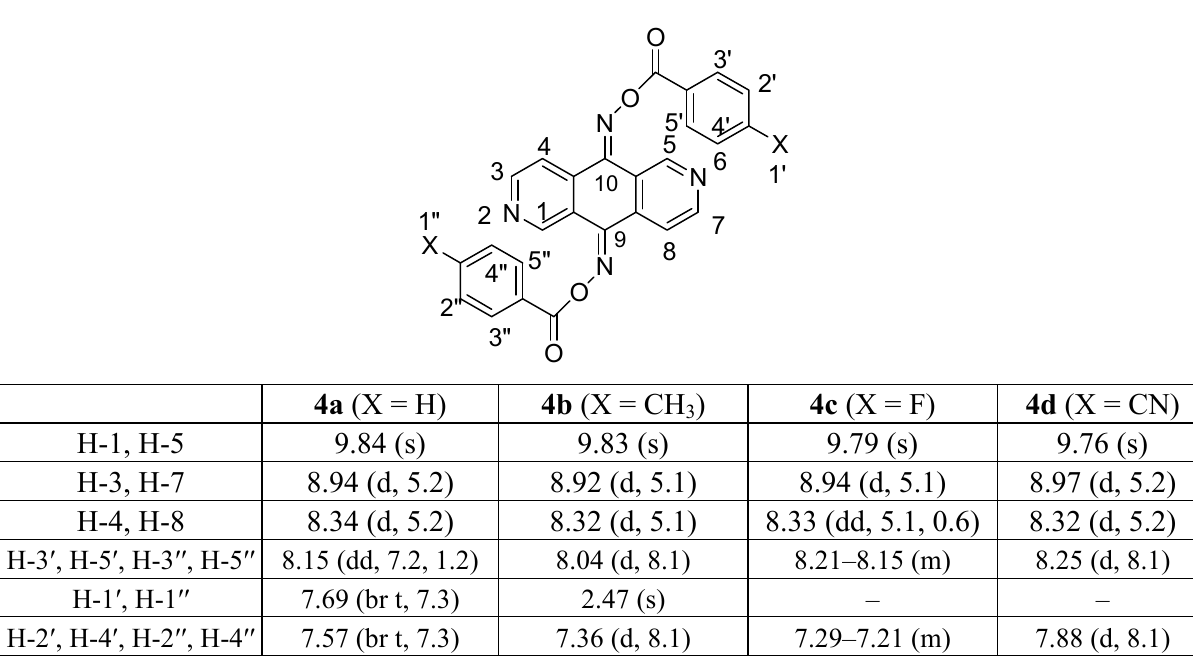
Table 2. The characteristic 1 H-NMR absorptions for compounds 4a – d a